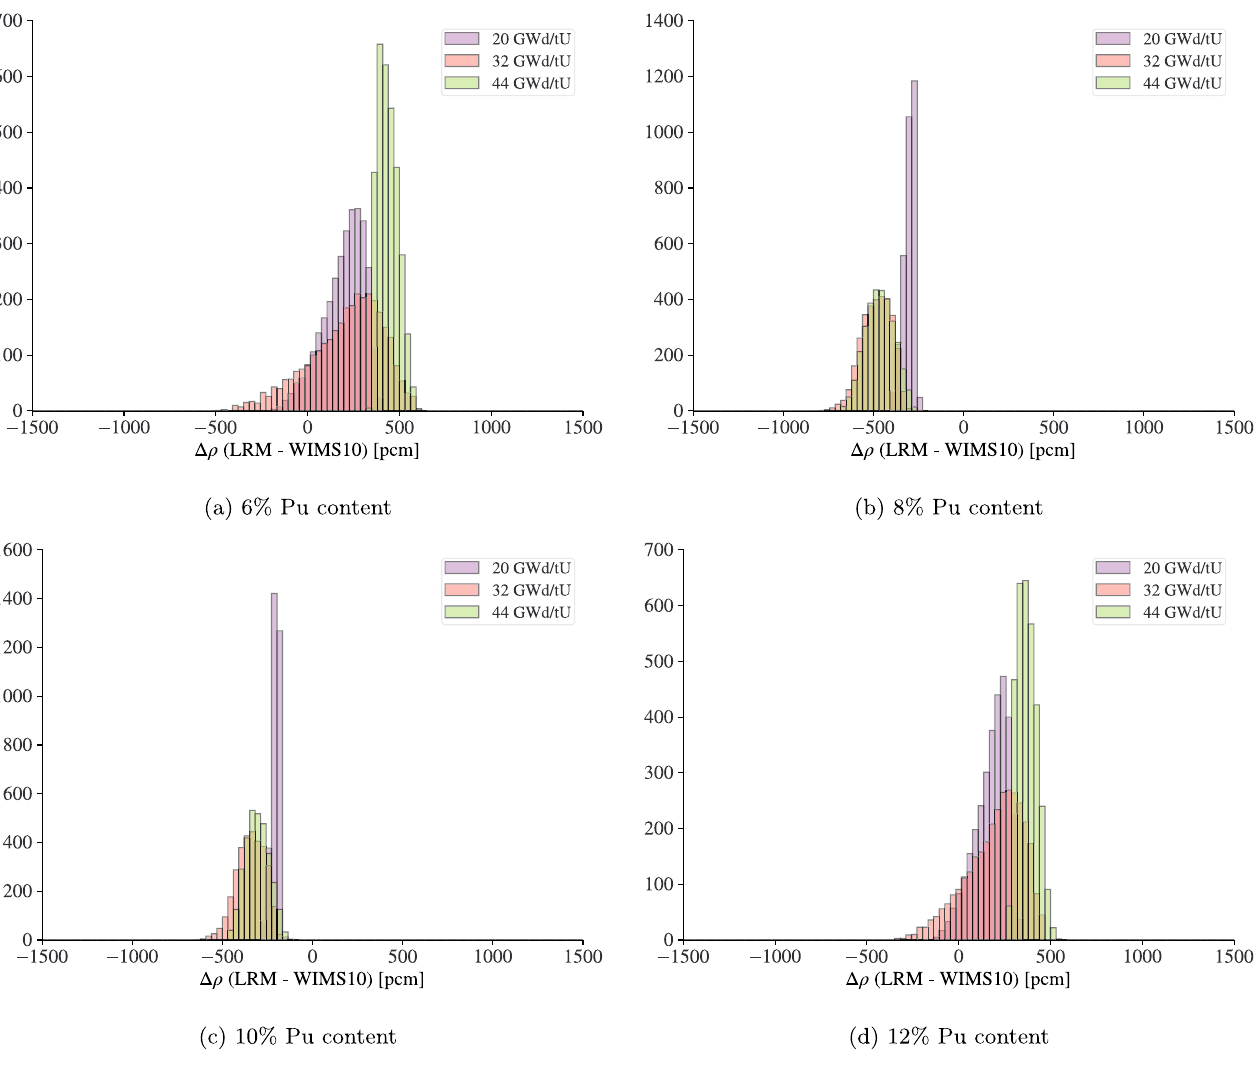
Fig. 4. Distribution of reactivity discrepancy (LRM - WIMS10) for the ensemble of generated MOX data